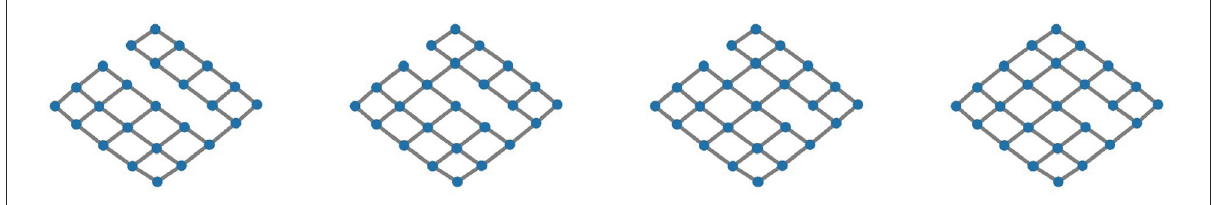
FIGURE5 Illustration of the local optimization-based recovery process.